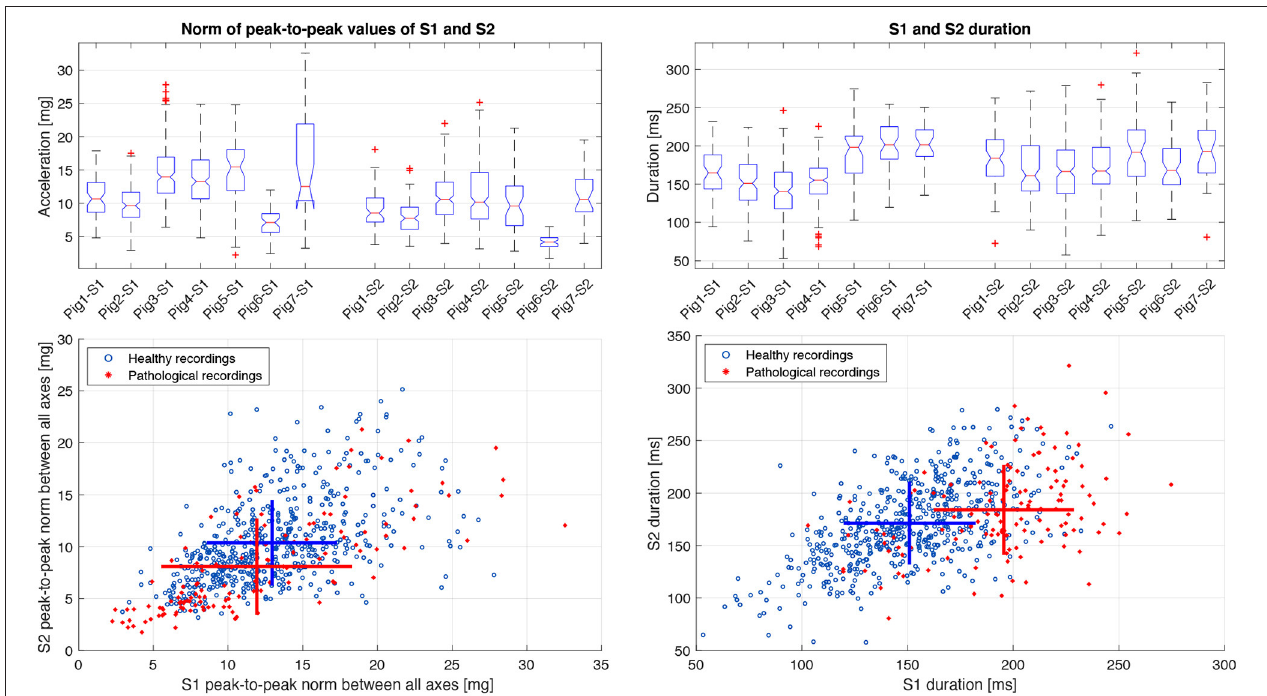
FIGURE 10 | Statistical distribution and scatter plot of the norm of the peak-to-peak values between all ACC axes and the duration of S1 and S2 between healthy and pathological pigs. The crosses in the scatter plot represent the mean and standard deviation of each population.